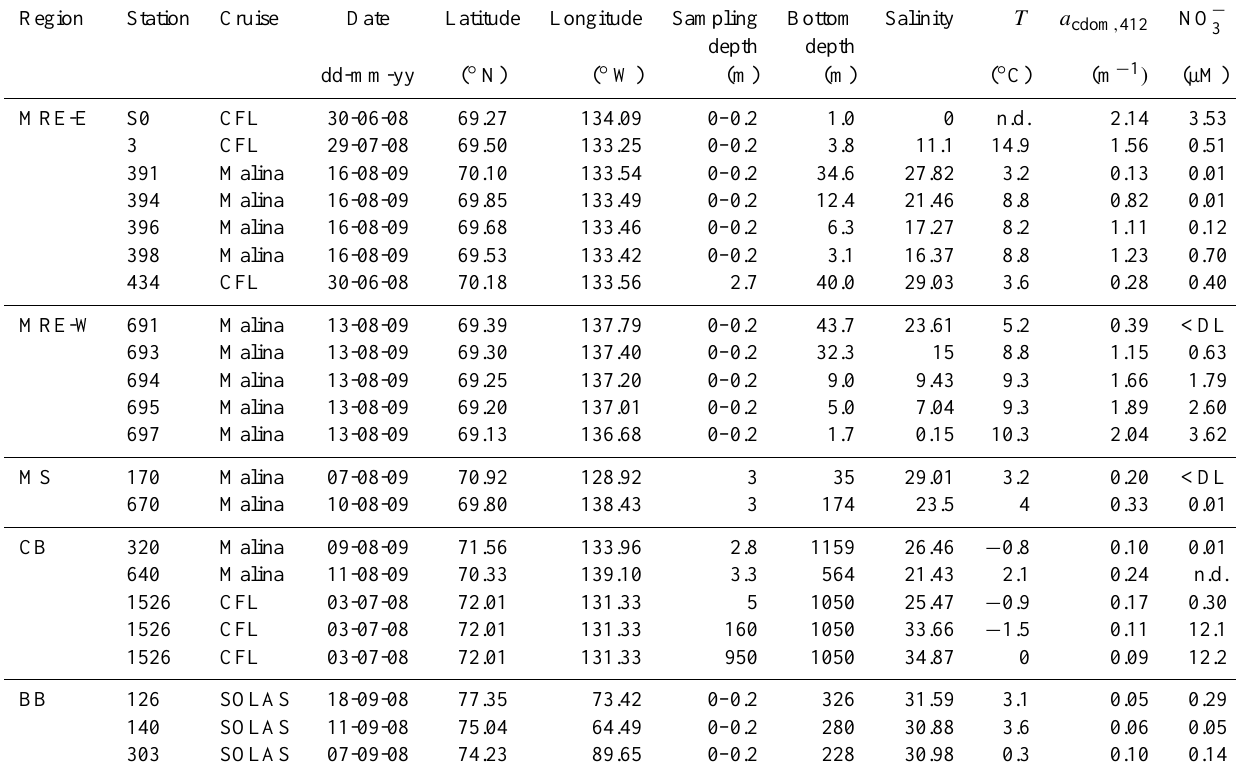
Table 1. Sampling information and related physical and chemical properties. MRE-E: Mackenzie River estuary east channel; MRE-W: Mackenzie River estuary west channel; MS: Mackenzie Shelf; CB: Canada Basin; BB: Baffin Bay; n.d.: not determined; <DL: under the detection limit. Sampling depths of 0–0.2m denote bucket samples. The separation of MRE-E and MRE-W from MS is only intended to facilitate discussion in the text. All MRE-E and MER-W stations were actually located on the